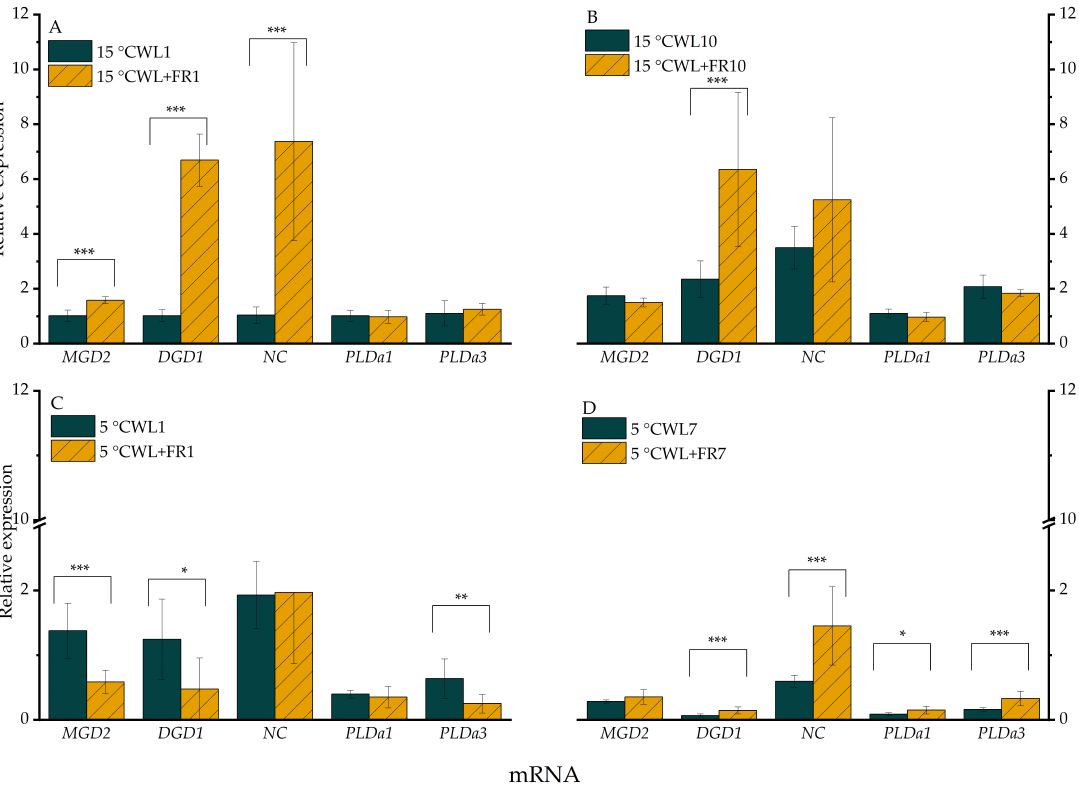
Figure 2. Relative expression levels of selected genes in leaves of barley “Nure” plants incubated at 15 ◦ C for 1 day ( A ) and for 10 days ( B ), and leaves grown at 5 ◦ C for 1 day ( C ) and for 7 days ( D ), under WL and WL + FR. Mean values ± SD of 9 independent biological replicates are shown. Significance levels are designated as * p < 0.1, ** p < 0.05, *** p <